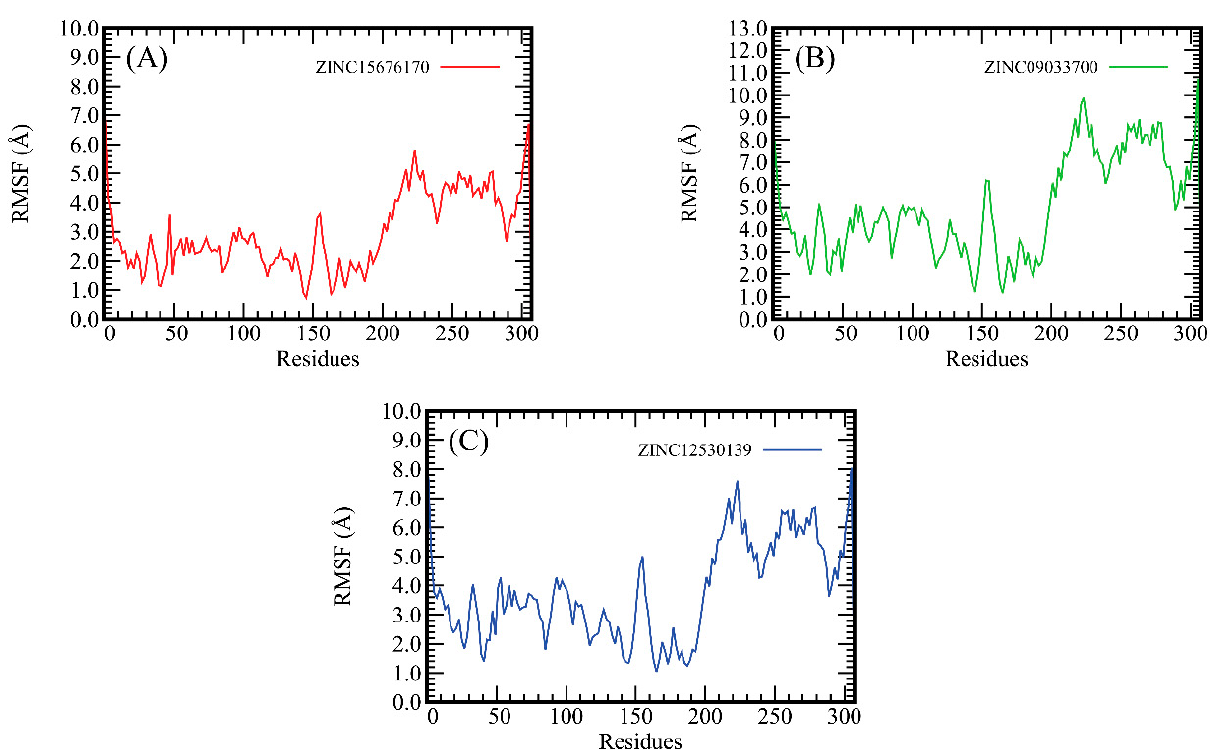
Figure 1. RMSFs of all systems including ZINC15676170 (red), ZINC09033700 (green), and ZINC12530139 (blue). The abscissa represents the residue number. The ordinate represents the value of Root-Mean-Square Fluctuation, and the unit is angstrom. Table 3. Energy decomposition of MM-GBSA free energy for ZINC15676170. All energies are in